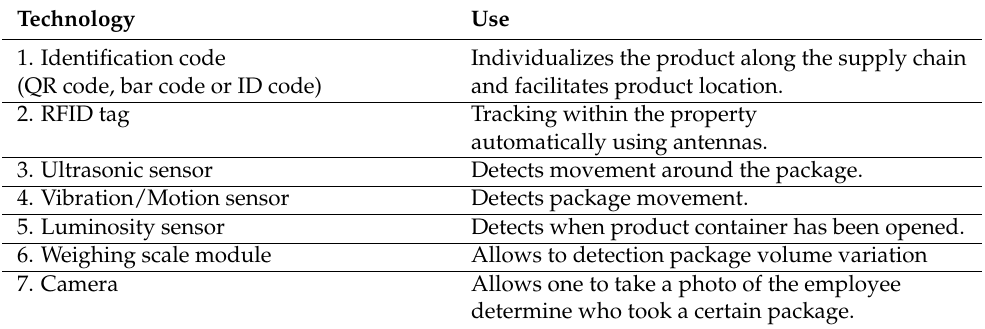
Table 2. Sensors per type of processing use in tier